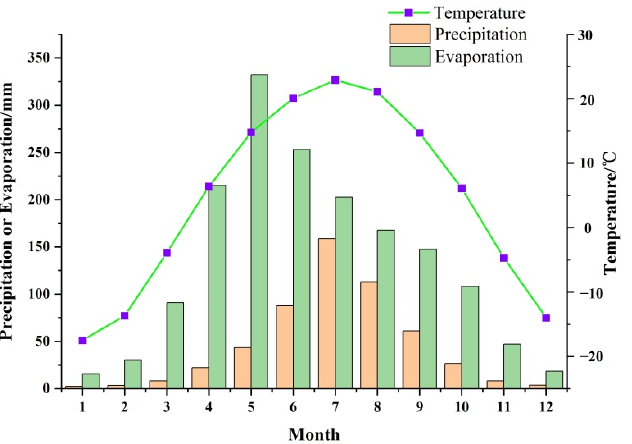
Figure 2. Monthly average values of precipitation, evaporation and temperature in the northern part of Changchun city from 1962 to 2000.